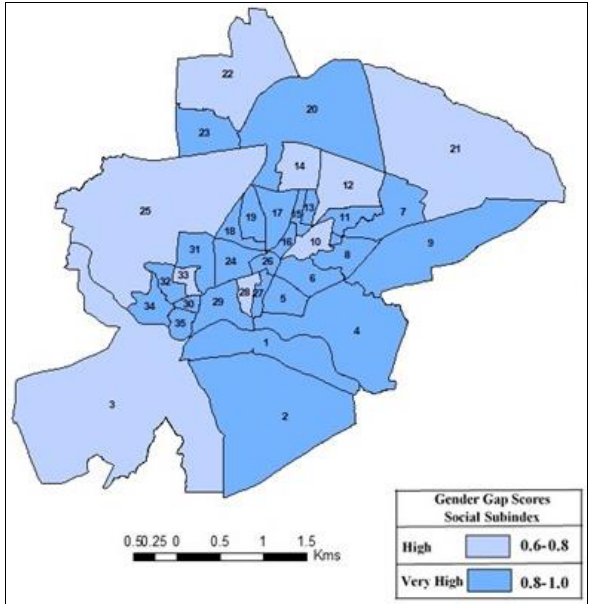
Fig. 3. Scores for the Survival subindex, Gender Gap Index, for Sehore M.C., 2011